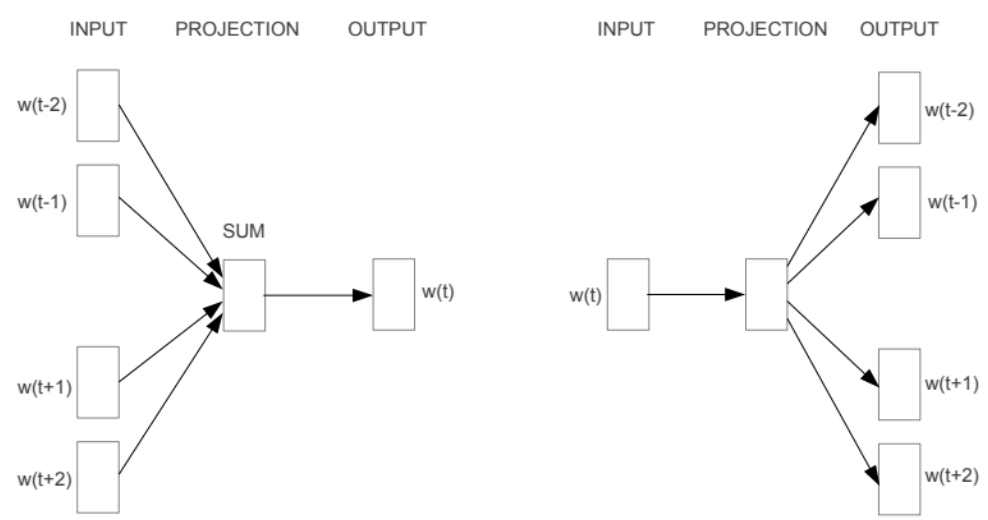
Figure 2. Word2vec’s model architectures. The continuous bag of words (CBOW) architecture predicts the current word based on the context, and the skip-gram predicts surrounding words given the current word [34].